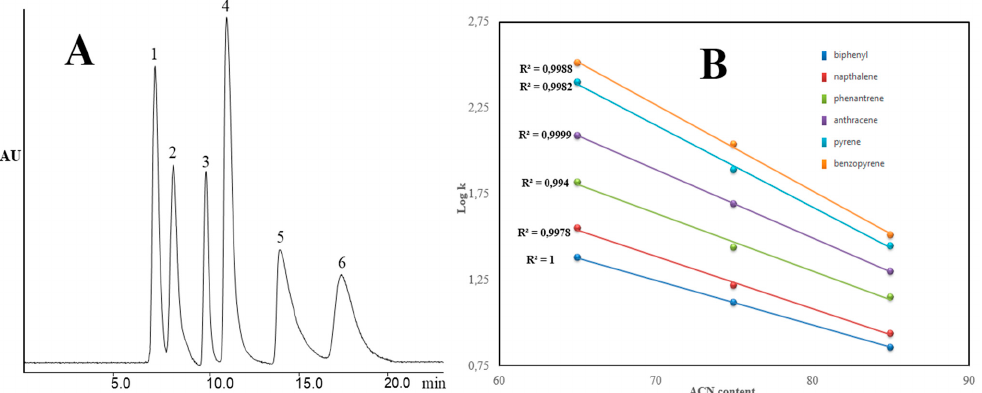
Figure 6. ( A ) Separation chromatogram of PAHs on Column 7. Chromatographic conditions: mobile phase. 80% ACN:20% H 2 O ( v / v ); column dimensions, 13 cm × 50 µm i.d.; analyte concentration, 0.03 µg/mL; detection wavelength, 220 nm. Order of peaks; (1) biphenyl (2) naphthalene, (3) phenanthrene, (4) anthracene, (5) pyrene, (6) benzopyrene. ( B ) The effect of ACN content on retention of PAHs using Column 7. The other conditions are the same as in ( A ).